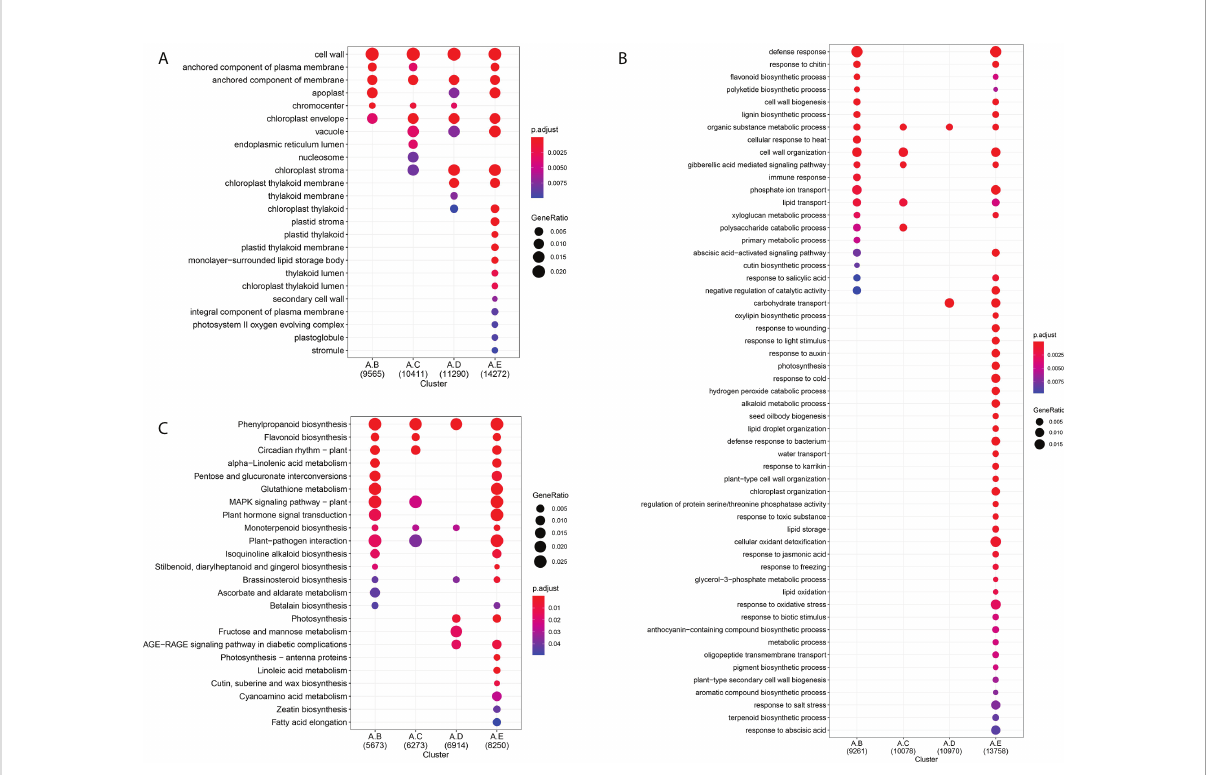
FIGURE 3 GO and KEGG enrichment analysis of DEGs related to seed germination by 4°C treatment for 0d, 14 d, 28 d, 42 d or germination. (A) GO analysis of the terms enriched in the DEGs among to the 4 comparisons (A vs B, A vs C, A vs D, A vs E). The top 24 terms of most enriched GO terms belong to cellular composition. padj < 0.01. (B) The top 55 terms of most enriched GO terms belong to biology process. padj < 0.01. (C) KEGG enrichment pathways. The left side of each fi gure represents the enriched function terms. The dot size indicates the number of GeneRatio. padj < 0.05.